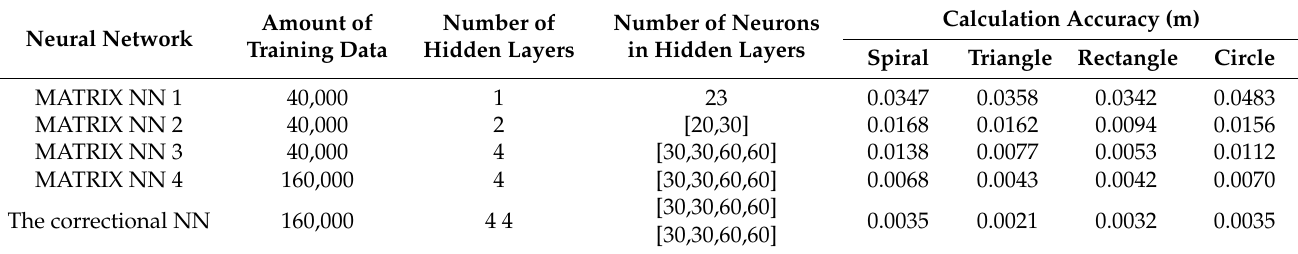
Table 5. The IKP NN prediction